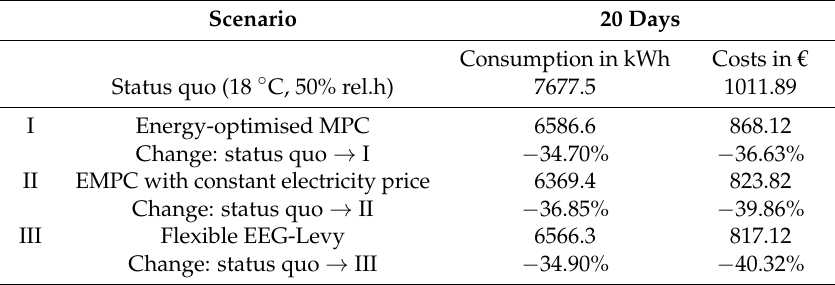
Table 3. Energy consumption and costs over 20 days in January under different